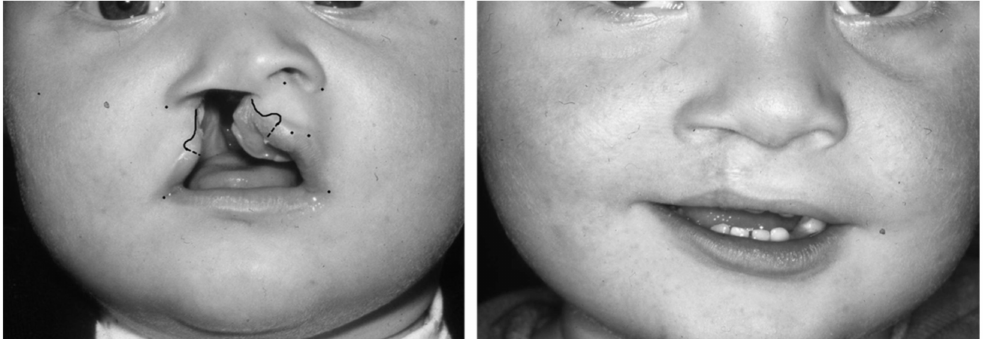
Figure 1. Indicating the lip markings according to Pfeifer’s technique [9].